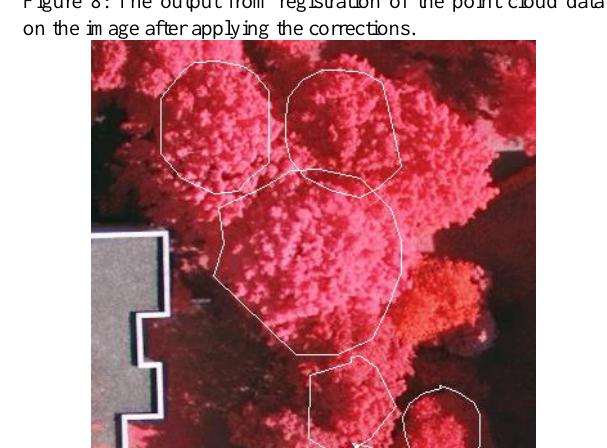
Figure 9: The extracted boundary of single trees.